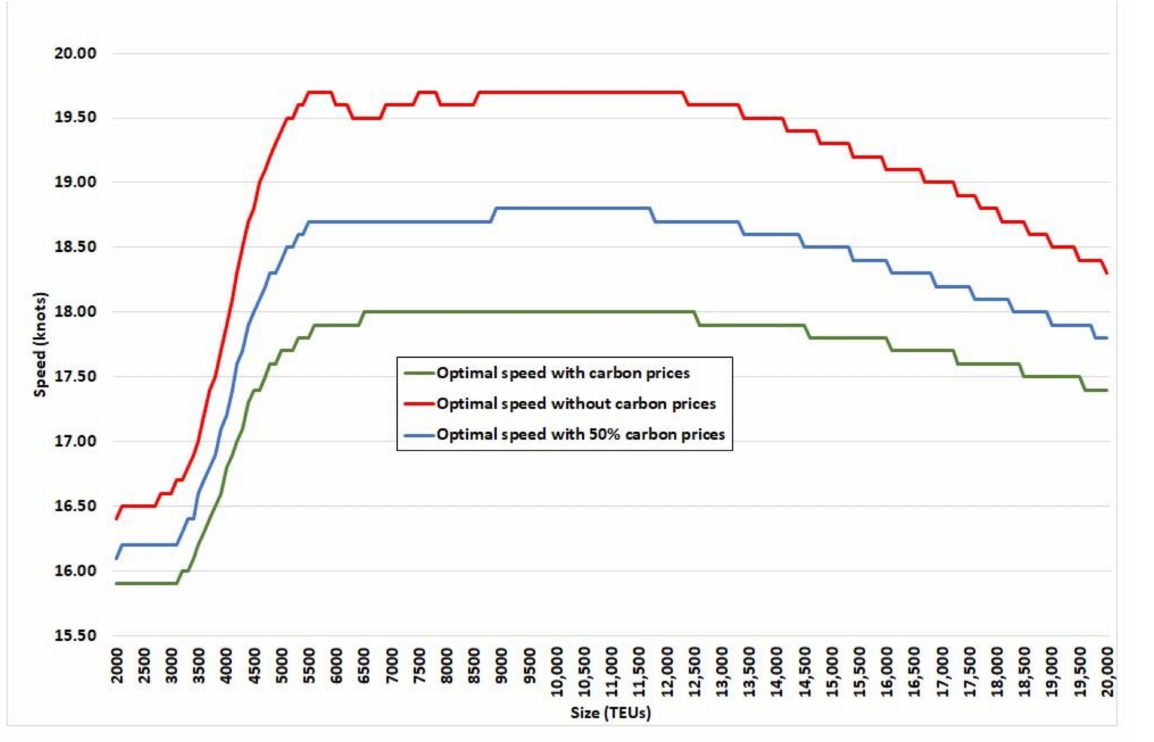
Figure 11. Optimal speeds as a function of size